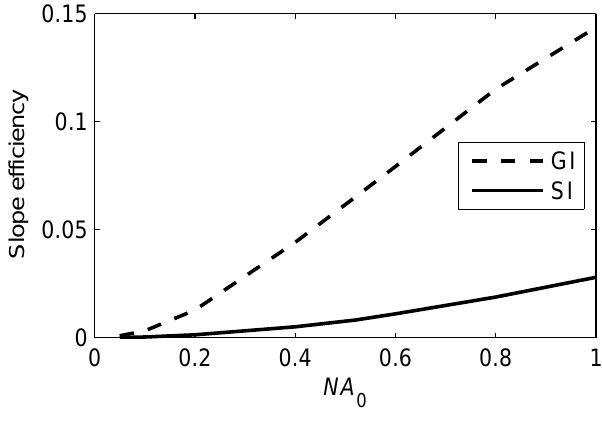
Figure 9. Evolution of the slope efficiency at 581 nm for different values of the numerical aperture when the fiber is pumped: SI (solid line) and GI POFs with γ = 1.43 (dashed line). Parameters as in Table